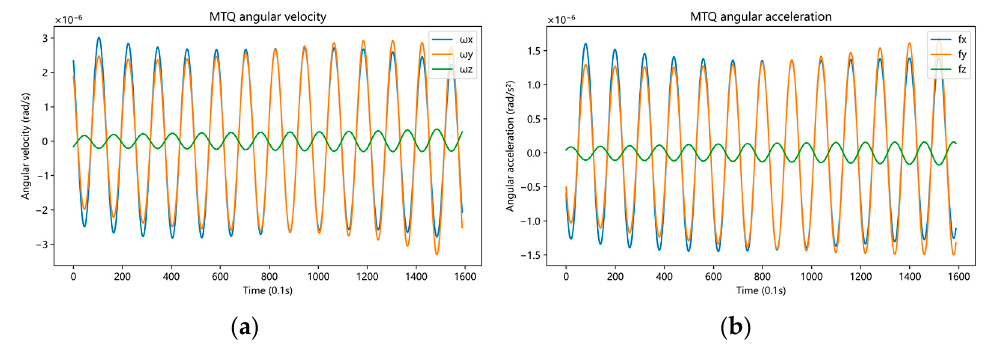
Figure 7. Angular velocity and angular acceleration of MTQ are interpolated after filtering: ( a ) MTQ angular velocity; ( b ) MTQ angular acceleration.